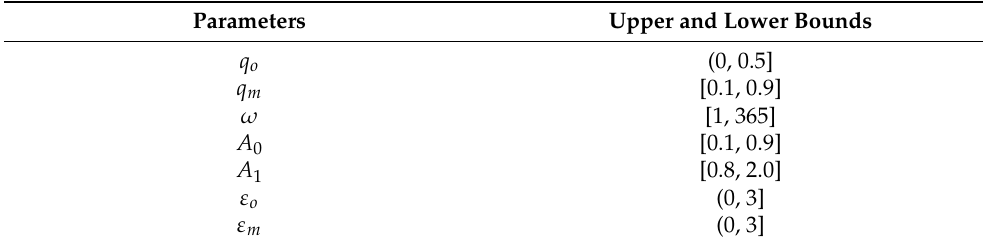
Table 2. Upper and lower bounds of fitted parameters for the